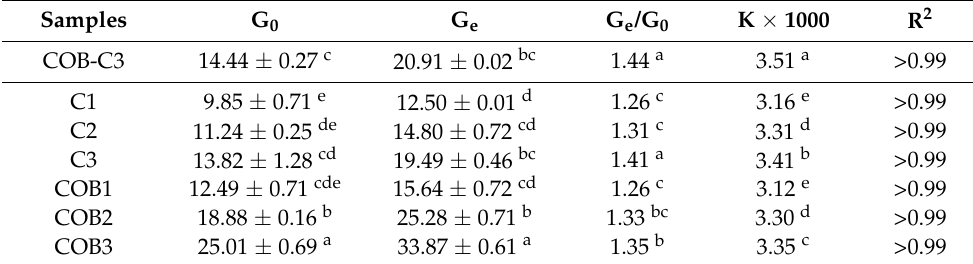
Table 4. The 3-ITT rheological properties of plant-based ice cream mixes.